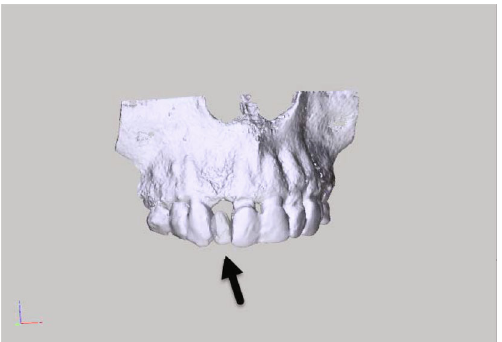
Figure 3: Rendered 3D planning model (STL fi le) showing a bony de fi cit in region 12.